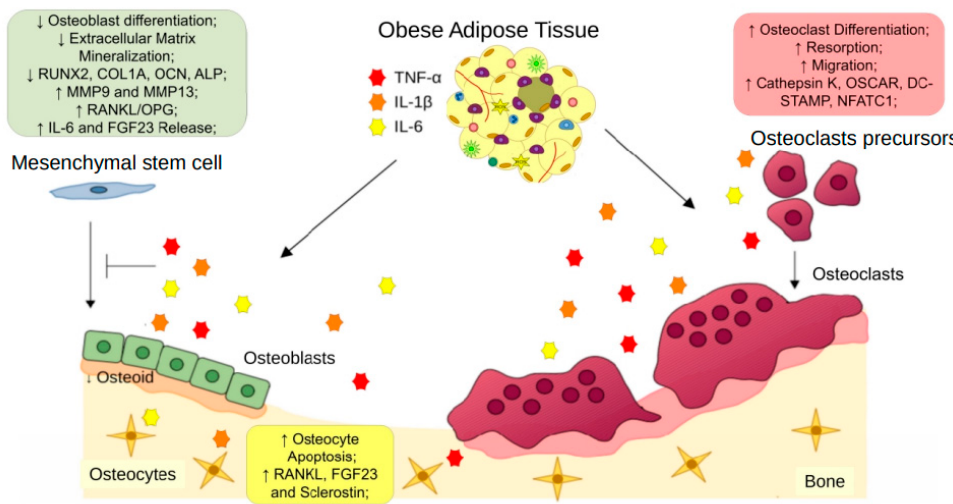
Figure 2. Obese adipose tissue-derived proinflammatory cytokines on bone remodeling. Pro- inflammatory cytokines, such as TNF- α , IL-6, and IL-1 β , released by obese adipose tissue, exert effects on osteoclast precursors, increasing osteoclast differentiation and resorption. Moreover, these cytokines reduce the osteogenic differentiation of mesenchymal stem cells and compromise osteoblast bone formation. TNF- α , IL-6, and IL-1 β also promote apoptosis and increased expression of osteoclast stimulation factors by osteocytes. The unbalanced activities between osteoblasts and osteoclasts induce osteoporosis.